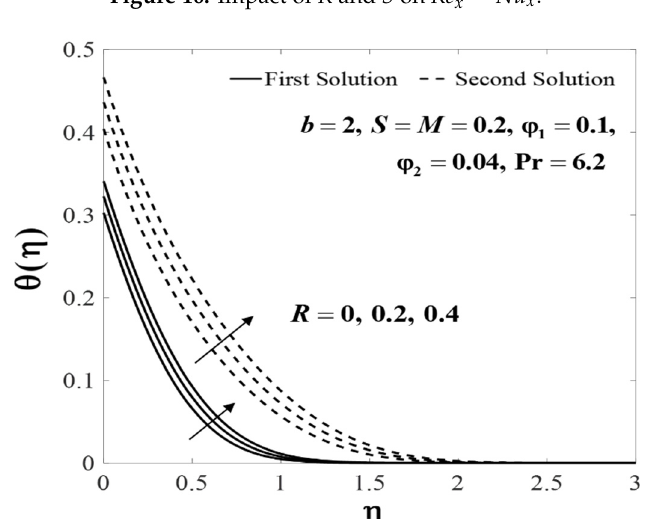
Figure 17. Impact of 𝑅 on 𝜃(𝜂) .